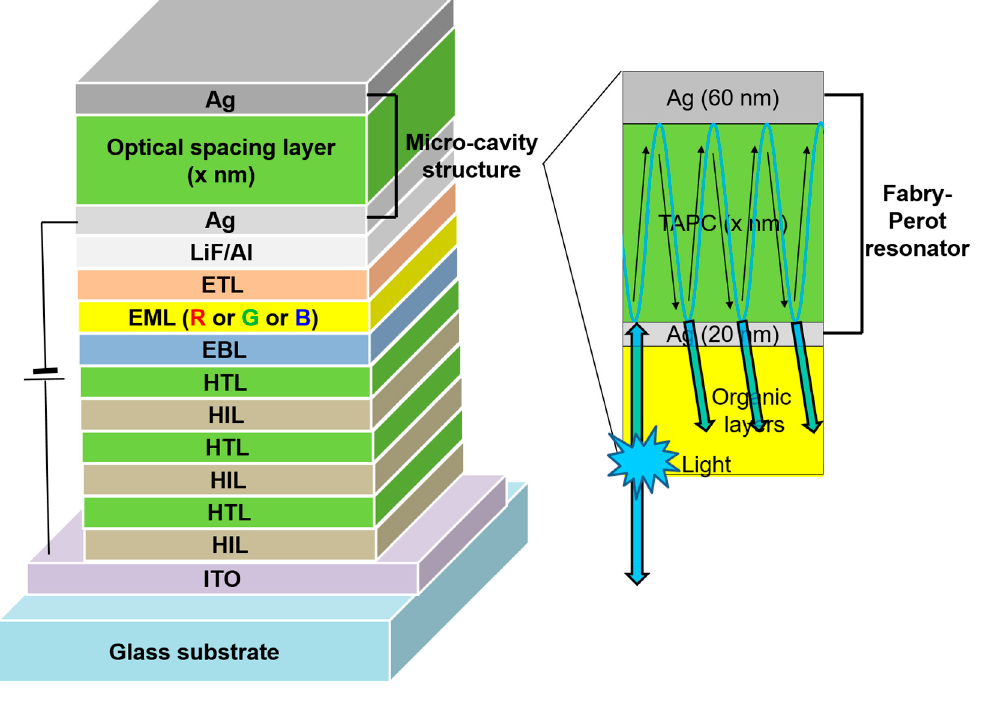
Figure 1. Structure of organic light-emitting diodes (OLEDs) with micro-cavity structure embedded cathodes ( x = 100, 110, 120, 130, 140, 150, 160, 170).